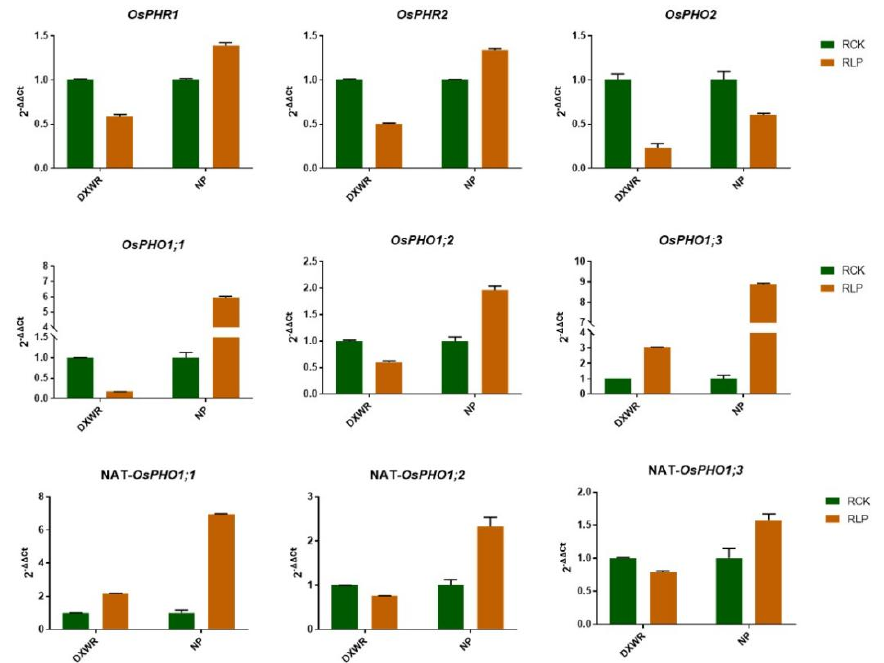
Figure 4. Expression pattern in DXWR and NP of key genes that characterized in cultivated rice participating in the P-regulation network detected by qRT-PCR. Error bar means standard devia- tion.